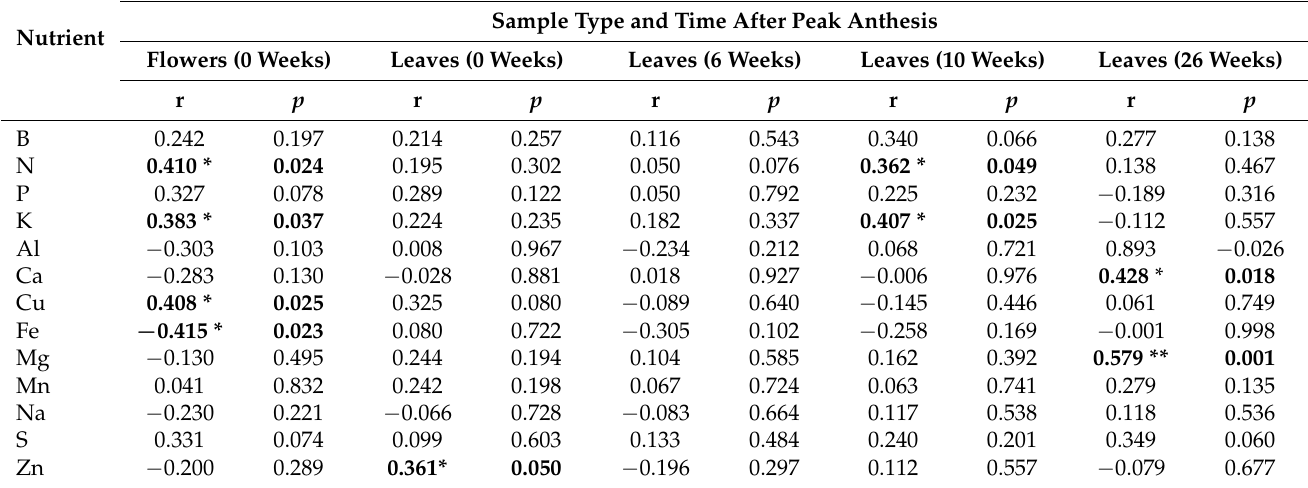
Significant correlations (r) are indicated by bold font and asterisks (* p ≤ 0.05, ** p ≤ 0.01, *** p ≤ 0.001; n = 30 trees).